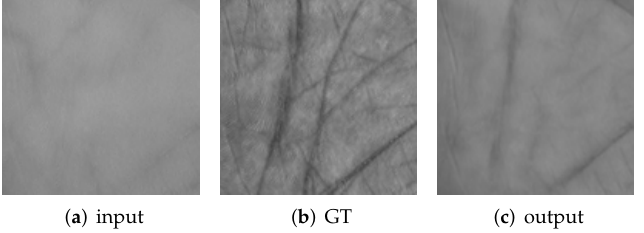
Figure 7. Failure case example. GT denotes the ground truth image in blue